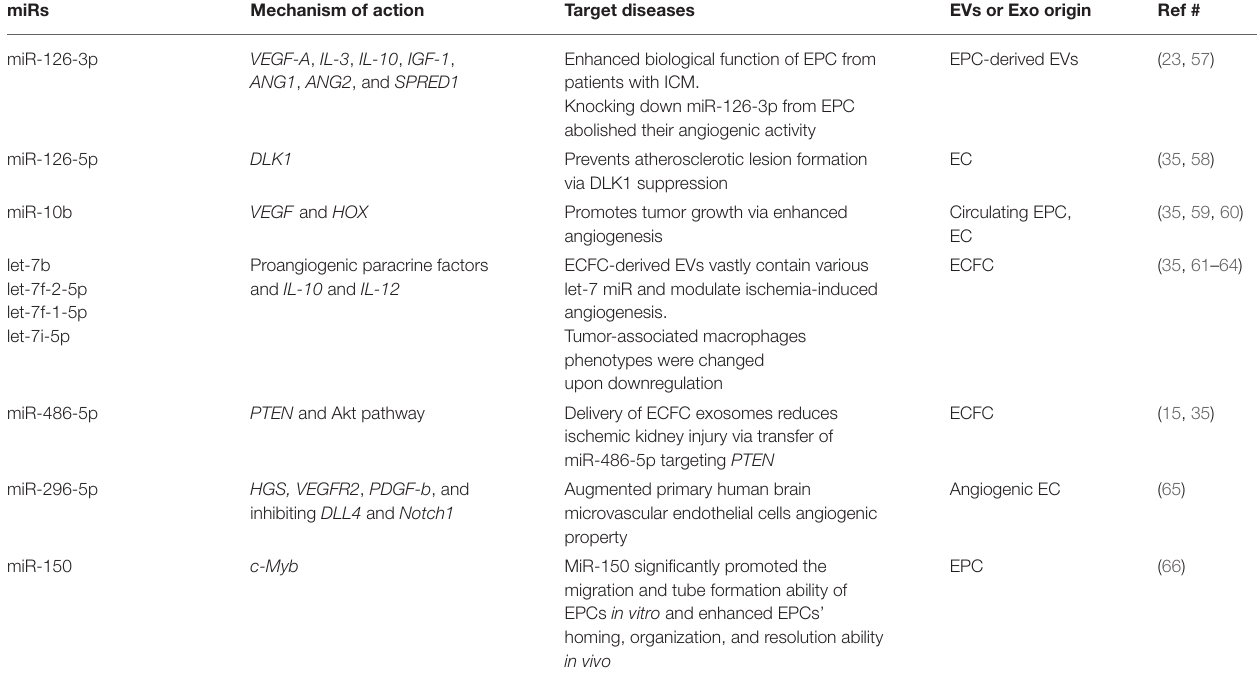
TABLE 1 | EPC-derived angio-miR. miRs Mechanism of